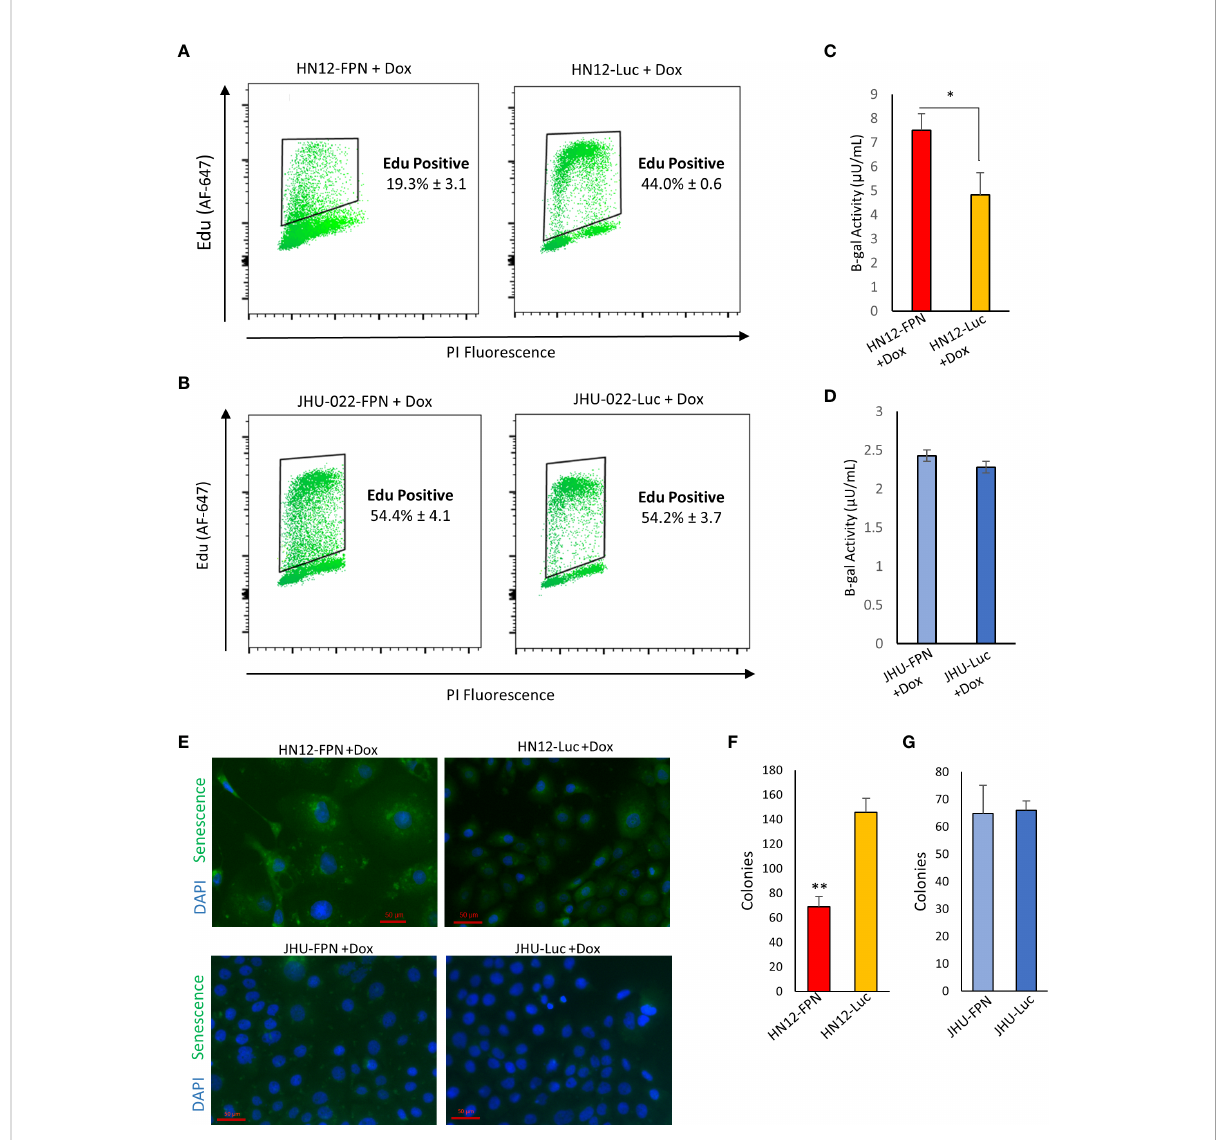
FIGURE 7 FPN expression induces senescence in HN12. (A) , (B) EDU incorporation of HN12-FPN/Luc (A) and JHU-022-FPN/Luc (B) grown with 0.5 m g/mL dox for 3 days. (C, D) . Beta-galactosidase activity of HN12-FPN/Luc (C) and JHU-022-FPN/Luc (D) after 7 days of exposure to 0.5 m g/mL dox. One m Unit is equal to 1 pmol of product generated per min. (E) HN12-FPN/Luc and JHU-022 FPN/Luc expressing cells were grown with 0.5 m g/ mL dox for 37 days and stained for senescence using CellEvent Green Senescence Kit (F) , (G) Clonogenic assay of HN12-FPN/Luc and JHU- 022-FPN/Luc expressing cells grown for 72 hours with 0.5 m g/mL after recovery in dox free media for 48 hours. (*P<0.05;